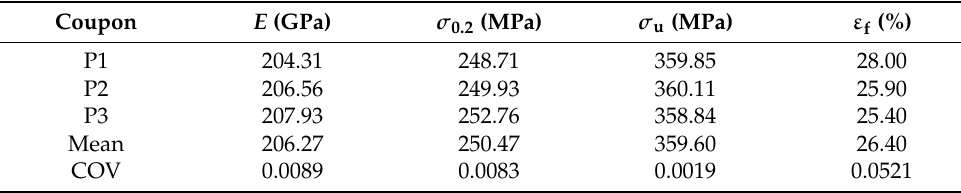
Figure 4. Typical stress–strain curves of the tensile coupons with a thickness of 1.2 mm.